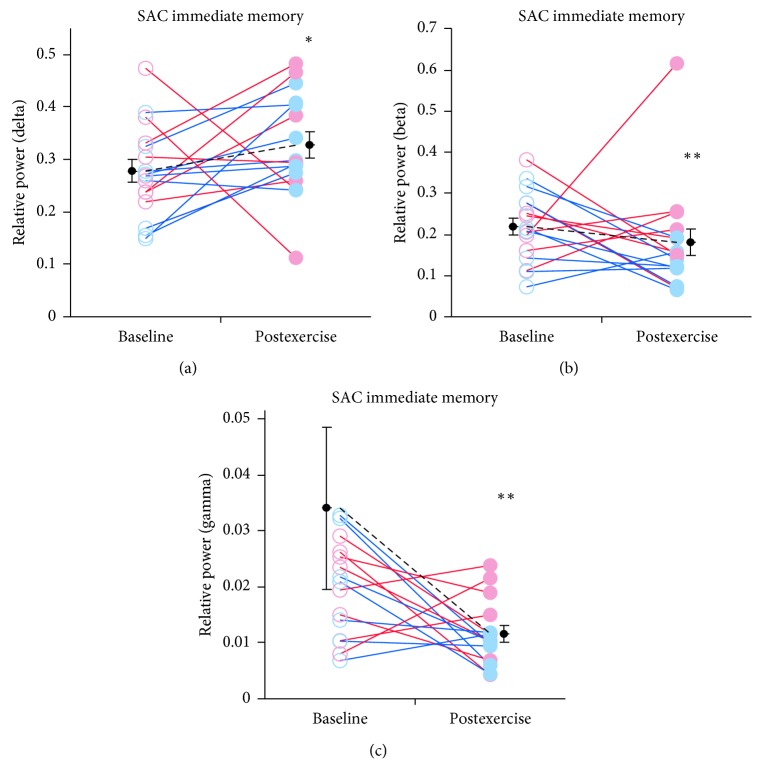
Effects of moderate exercise on qEEG relative spectral power bands during the immediate memory task of the SAC component of the SCAT3. Spectral power was quantified from each subject during each cognitive task. (a) Relative delta power was increased during the immediate memory task. (b) Relative beta power was decreased during the immediate memory task. (c) Similar to beta, gamma relative power was decreased during this task. One data point (gamma baseline value = 0.249) was not drawn for clarity. Plotting conventions are identical to Figure 1.